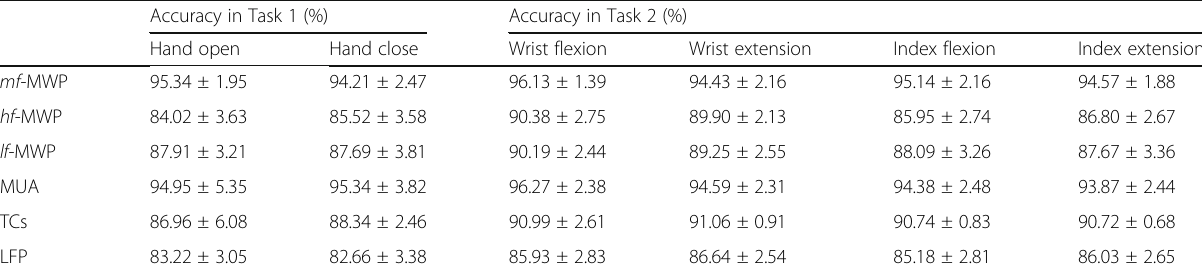
Table 4 Accuracy of the individual decoders when using different neural features as input Accuracy in Task 1 (%)